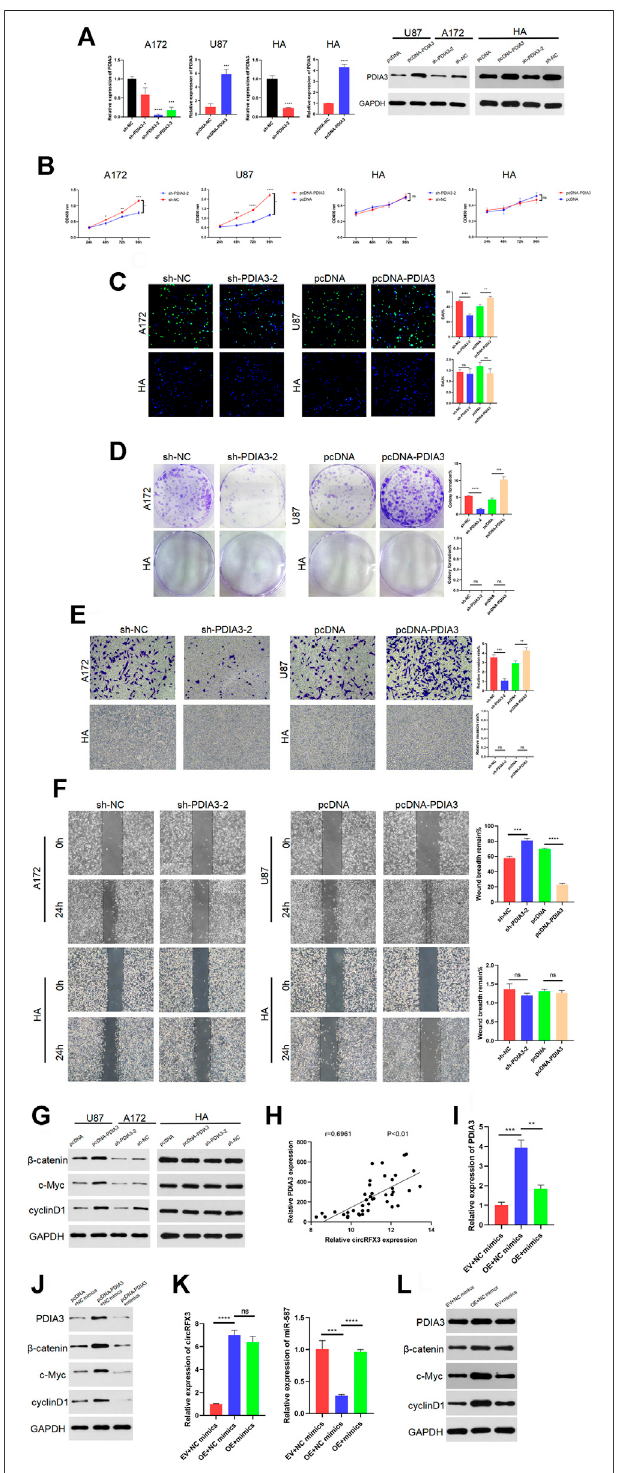
FIGURE 7 | PDIA3 played tumor-promoting roles in glioblastoma (GBM) cells, and circRFX3 regulated the miR-587/PDIA3/ β -catenin axis. (A) As the qPCR and western blotting results showed, PDIA3 expression was clearly suppressed by sh-PDIA3-1, sh-PDIA3-2, and sh-PDIA3-3 in A172 cells, and PDIA3 was obviously overexpressed in U87 cells and human astrocytes